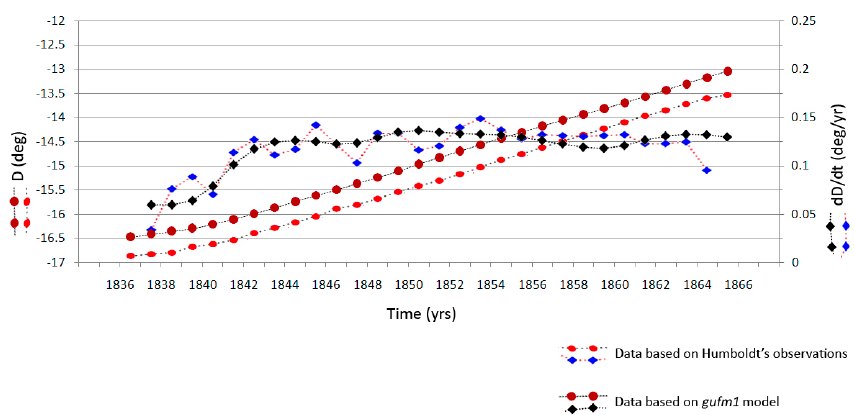
Figure 11. Declination values measured at Berlin observatory (latitude 52 ◦ 30 0 , longitude 13 ◦ 23 0 ) founded by Alexander von Humboldt (bright red circles) and declination values calculated according to gufm1 model (dark red circles) at latitude 52.5 ◦ , longitude 13.4 ◦ between 1836.5 and 1865.5. The corresponding time derivative values are plotted as well (blue rhombs for Humboldt’s observations, black rhombs for gufm1